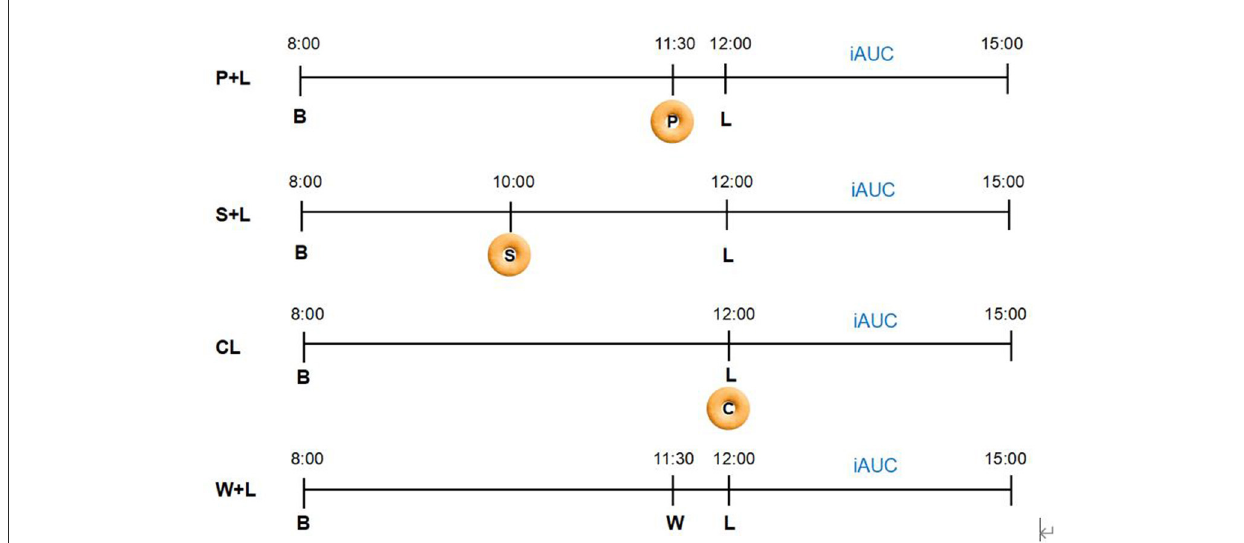
FIGURE1 Randomized crossover design. Participants will complete four test meals over 4 consecutive days in a randomized counterbalanced order using Latin Square Design. Participants will be randomized to receive one of the four meal arrangement orders as follows: (1) P + L → S + L → W + L → CL; (2)